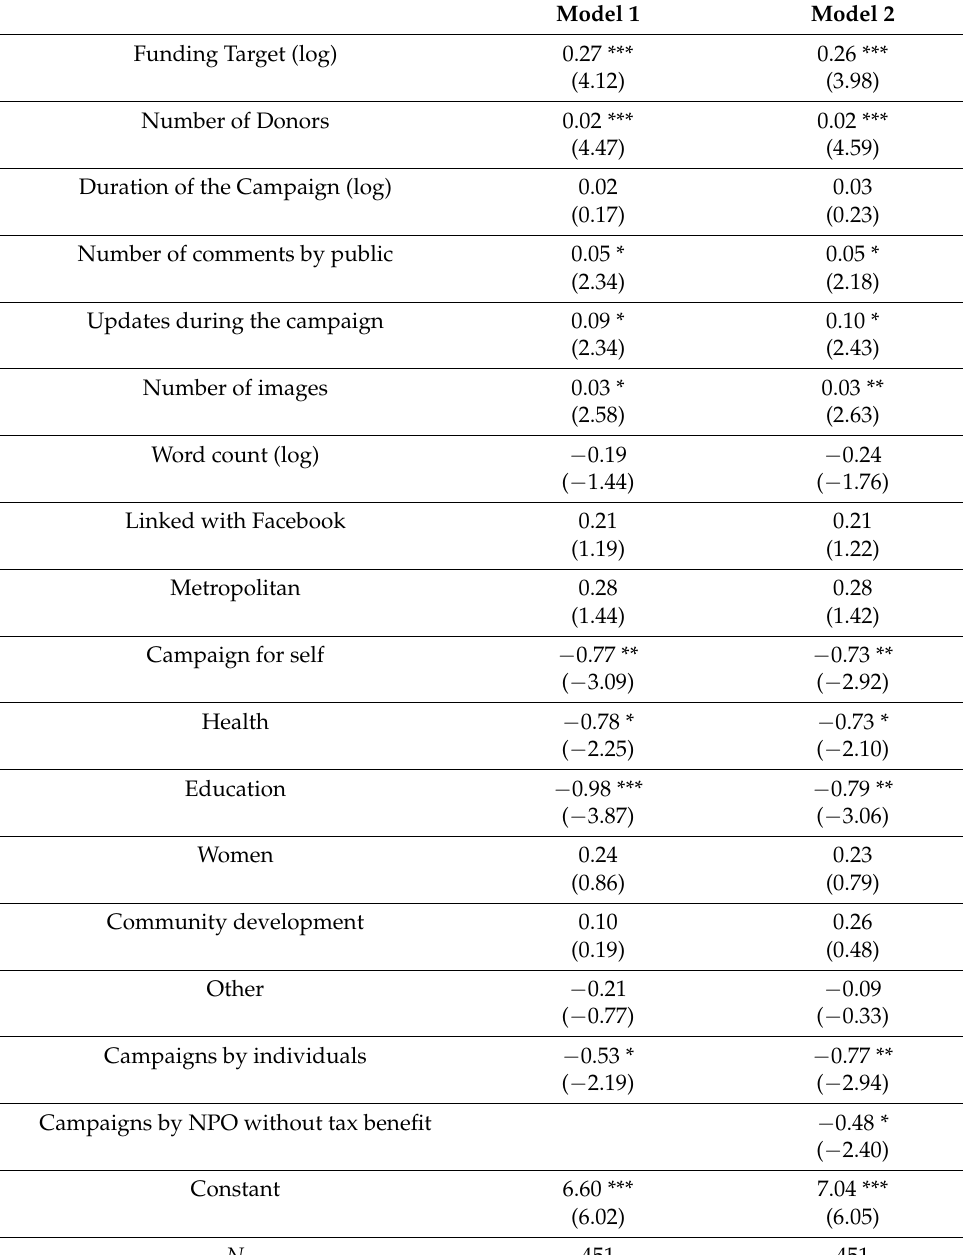
Table 4. Regression results for funding amount